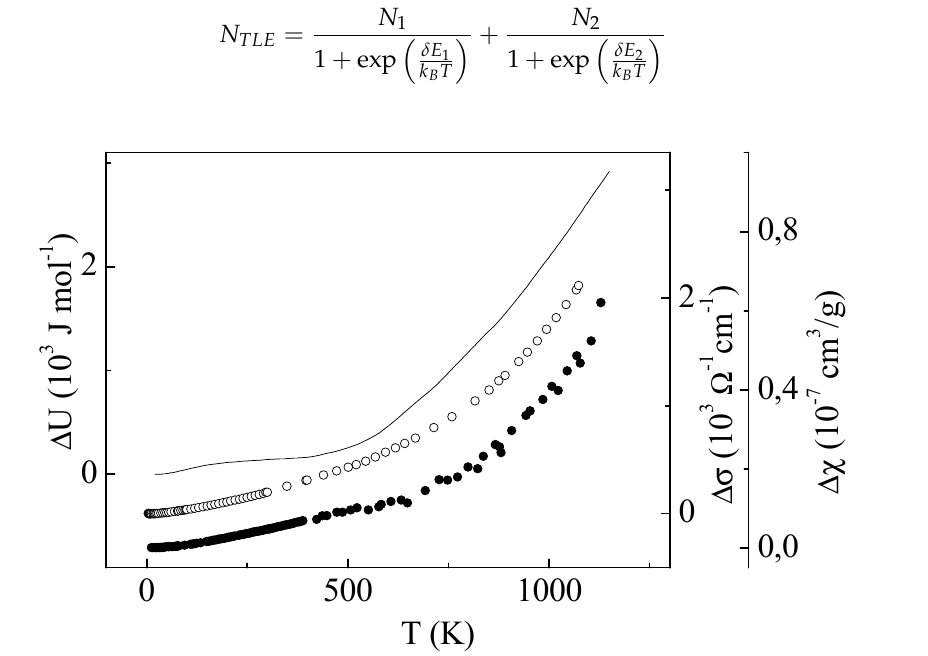
Figure 2. Curves of temperature-induced increments in theelectrical conductivity ∆ σ (open circles), paramagneticsusceptibility ∆ χ (closed circles), and internal energy ∆ U(solid line) of the Al 63 Cu 25 Fe 12 Figure 2 . Curves of temperature-induced increments in theelectrical conductivity Δσ (open circles), icosahedral phase in thetemperature range from 1.8 to 1000 paramagneticsusceptibility Δχ (closed circles), and internal energy Δ U(solid line) of the Al 63 Cu 25 Fe 12 icosahedral phase in thetemperature range from 1.8 to 1000 K.